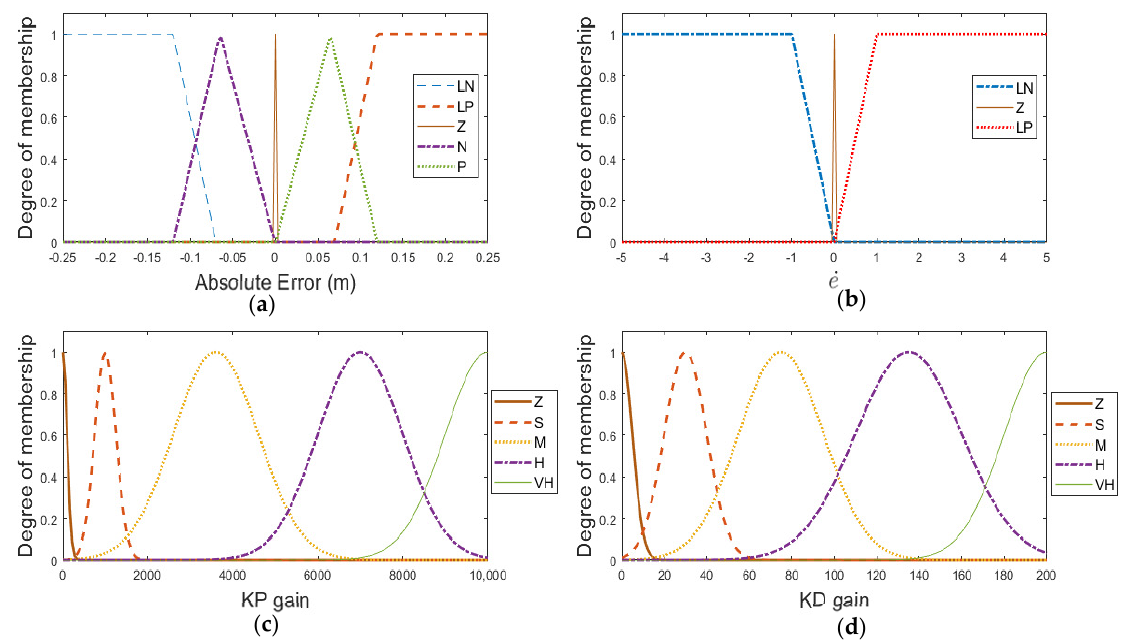
. e i ( b ), and outputs: kp ( c ) and kd ( d ).